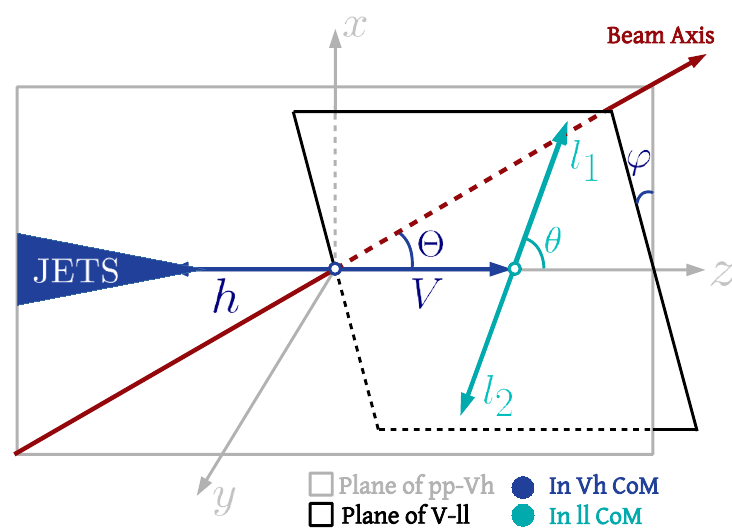
Figure 1 . Diagram showing the angles that can completely characterise our (cid:12)nal state. Note the use of two di(cid:11)erent frames of reference: the CoM frame of the V h system (in which ’ and (cid:2)